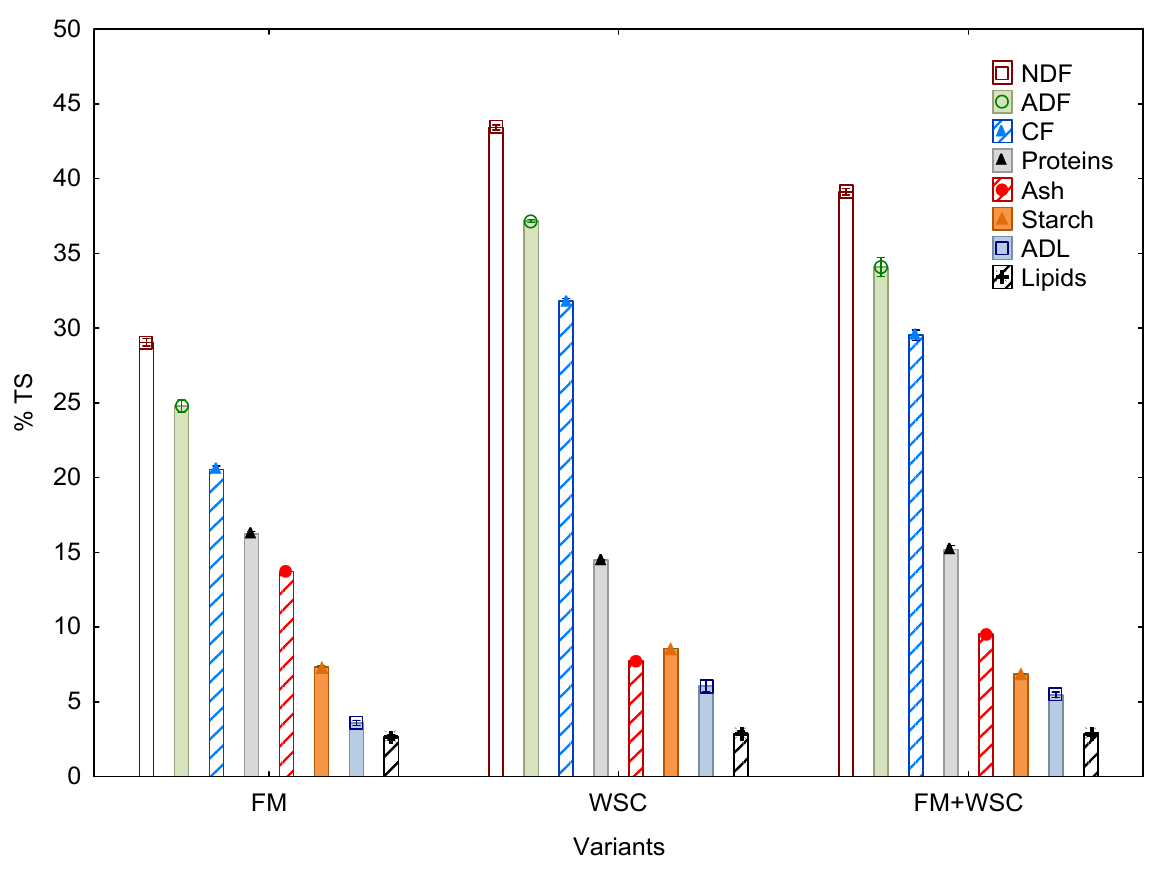
Figure 3. Qualitative parameters of silage (% TS) (average values of all parameters ( n = 3) for one parameter, ± SD). FM—fodder mallow, WSC—white sweet clover. Table 4. Significant differences between the individual variants.